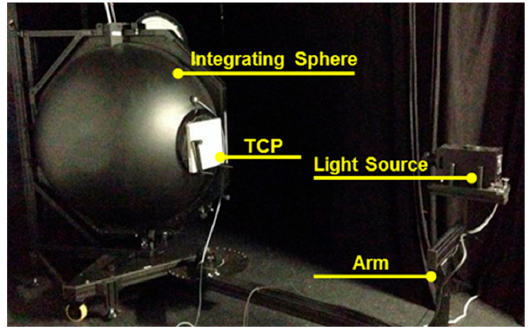
Figure 12. Layout of the test.